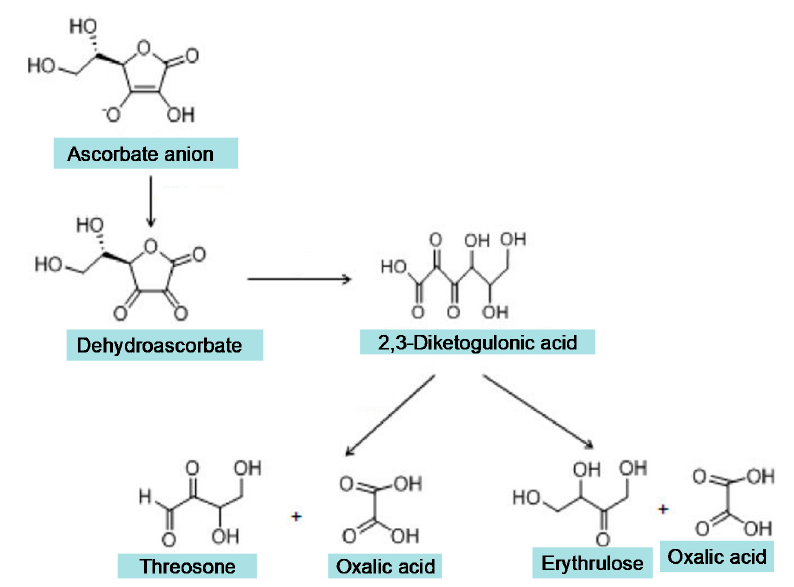
Figure 4. The non-enzymatic degradation of ascorbate to oxalate. Dehydroascorbate hydrolyses to 2,3-diketogulonic acid, which is then converted to erythrulose and oxalic acid. 2,3-Diketogulonic acid can also be converted to threosone and oxalate in the presence of hydrogen peroxide. All the degradation by-products, with the exception of dehydroascorbate, have ligands with iron and other metal binding potential. (Adapted from ref. [169]).